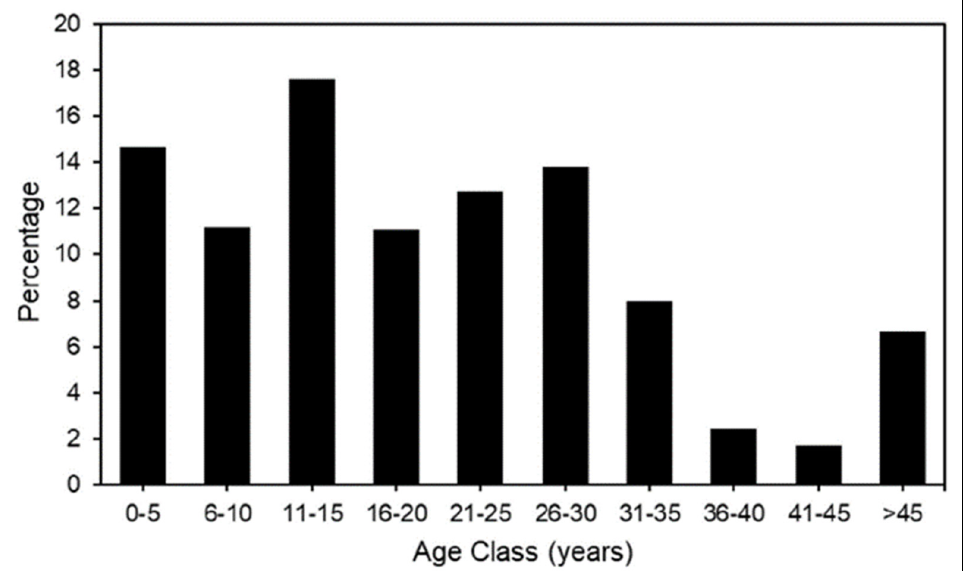
Figure 2. Distribution of age classes for loblolly pine at the start of the simulation period in the study area.